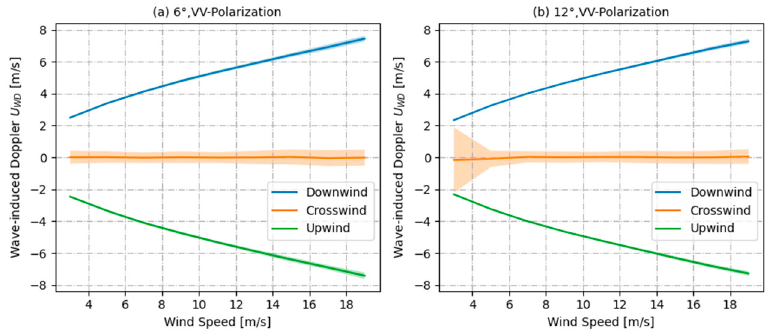
Figure 11. Variation in U WD and standard deviation with wind speed for radar incidence angles of 6 ◦ and 12 ◦ , azimuth angles of 0 ◦ , and 0 ◦ , 90 ◦ , and 180 ◦ wind directions without swell. The colored solid line indicates U WD , and the corresponding colored shading is the standard deviation.